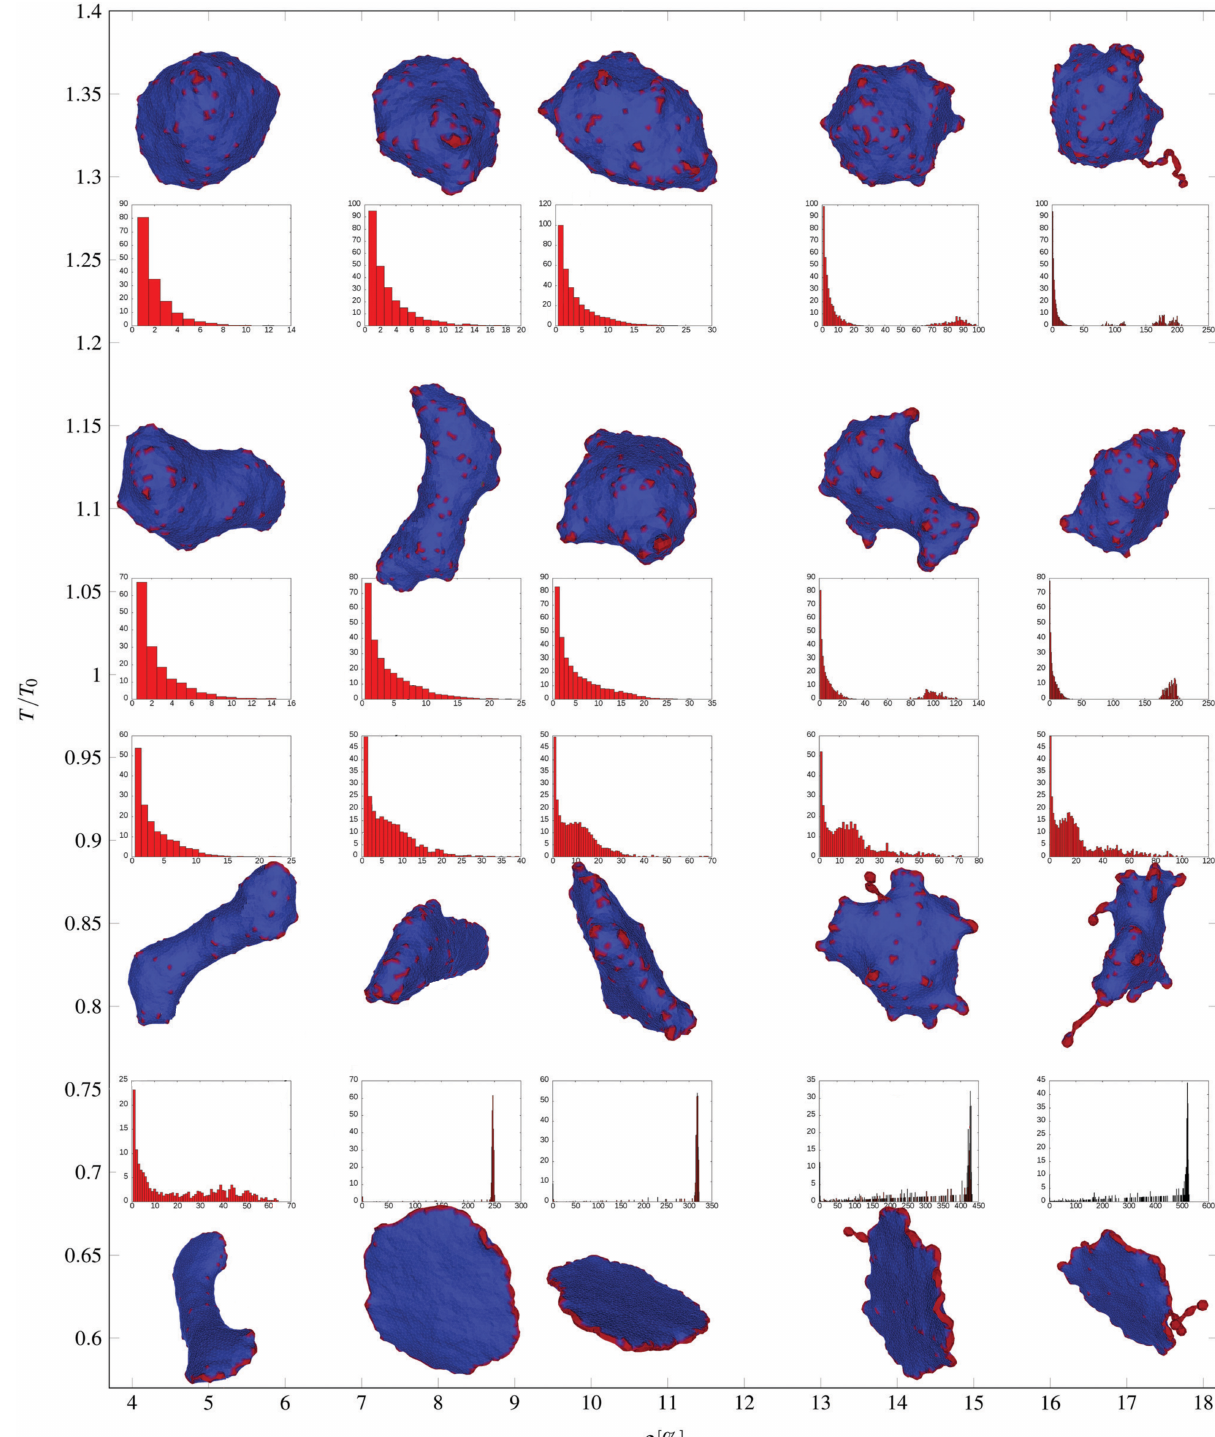
Figure 26. MC predicted vesicle shapes in thermal equilibrium with curved nanodomains and active protrusive force that is perpendicular to the surface and points outward at the positions of curved nanodomain clusters (red surface) with intrinsic curvature c 0 . The blue surface represents the nanodomain-free lipid bilayer and has zero intrinsic (spontaneous) curvature. In the corresponding cluster-size distributions, the y -axis represents the ensemble averaged number of nanodomain clusters of each size, while the x -axis is the size of the cluster of inclusions. Adapted with permission from ref. [24]. 2019 Royal Society of